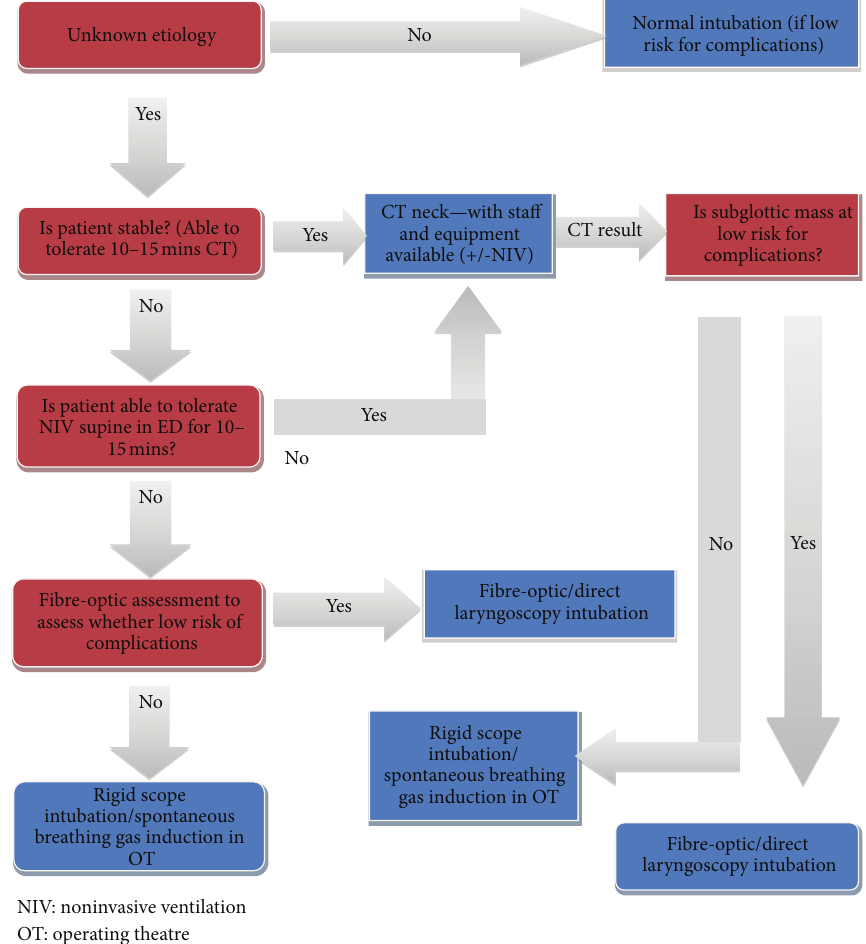
Figure 3: Difficult airway algorithm—suspected subglottic stenosis of unknown